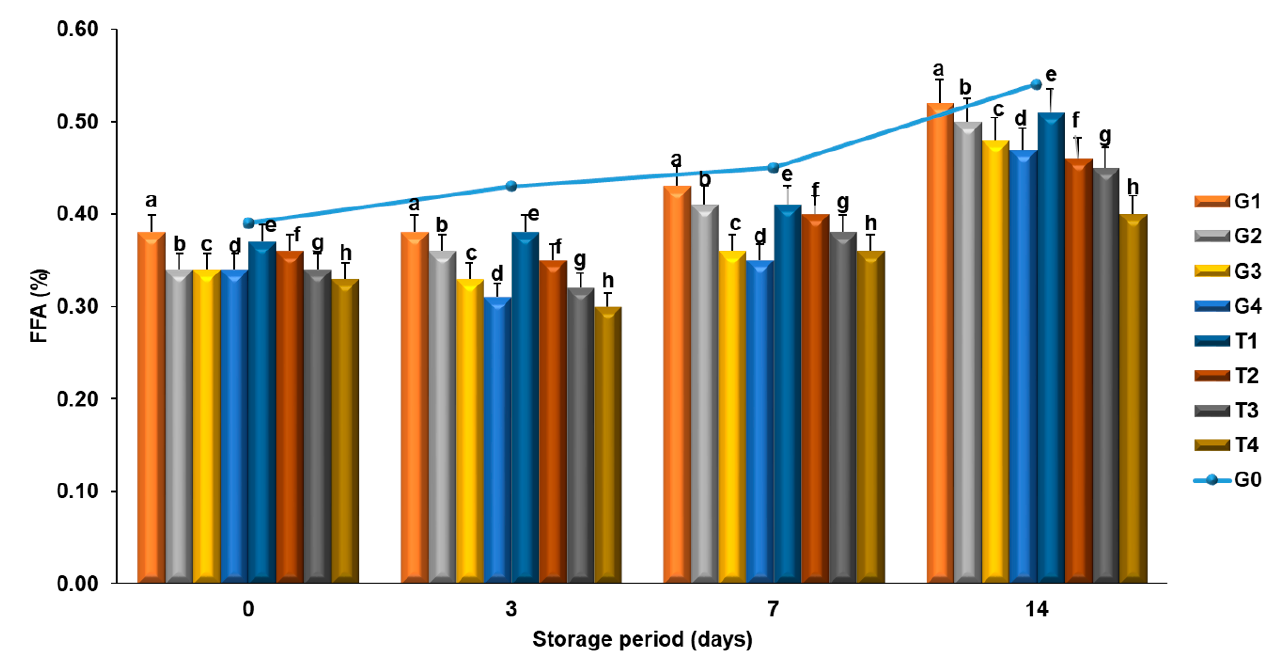
Figure 3. Effects of green tea powder, pomegranate peel powder, EP and PN on free fatty acids value of meatballs at different storage durations. The result was expressed as mean ± standard error. a–h For each day, columns representing different values are labeled with different letters.